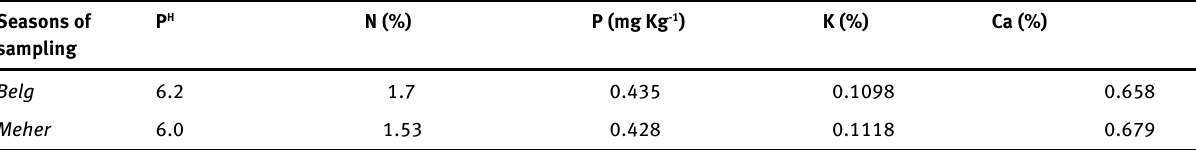
Table 2. Chemical properties of the compost used for the experiment in long and short rainy